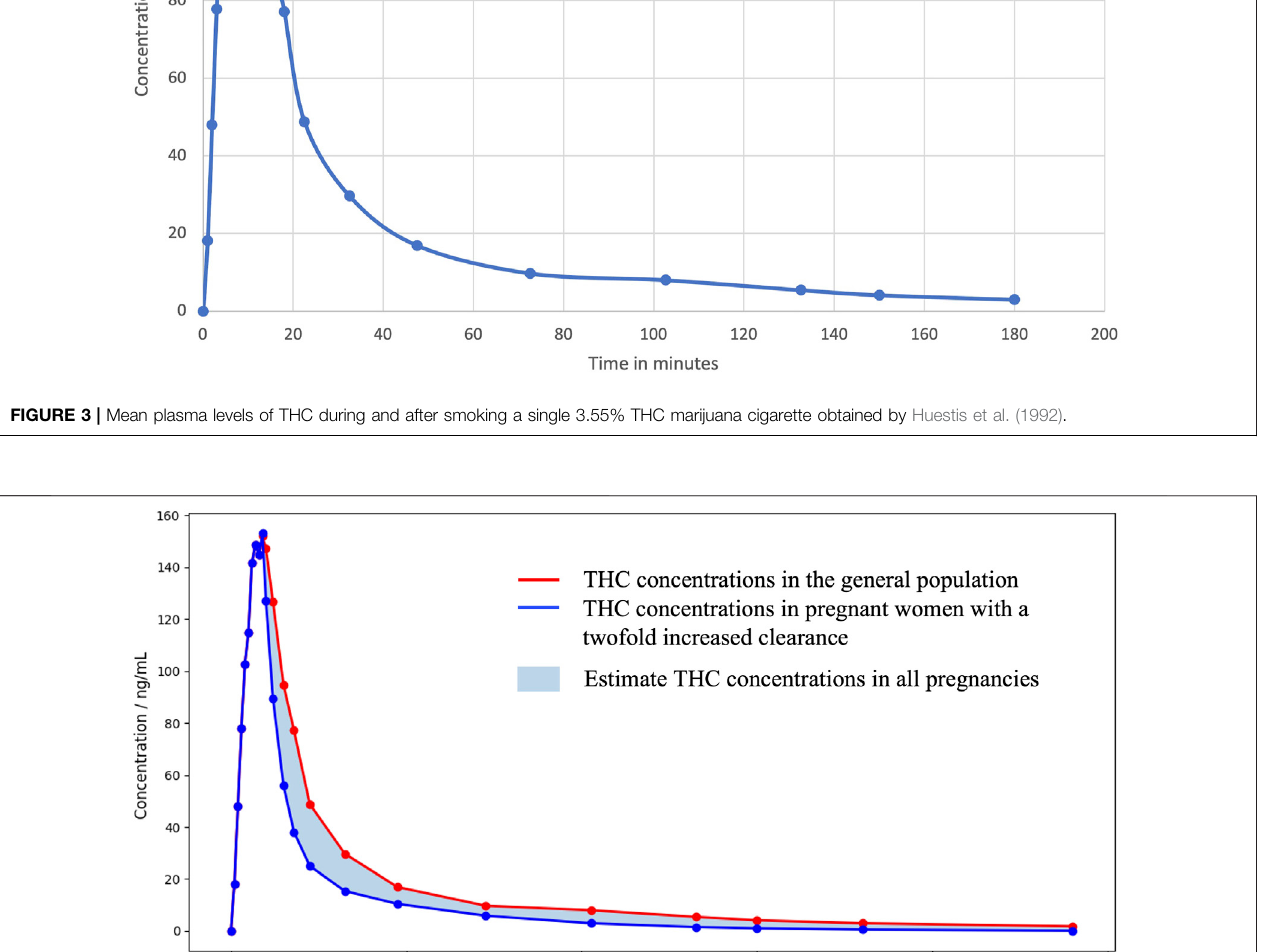
Frontiers in Pharmacology |